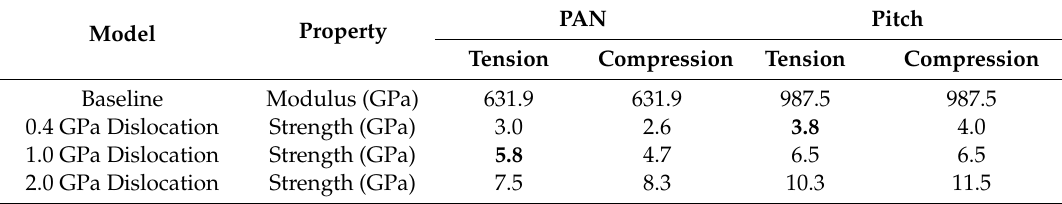
Figure 10. Tensile and compressive simulation stress/strain curves and final properties using crack dislocations between multiscale RVEs. ( a ) For pitch-based; ( b ) For PAN-based carbon fibers. Table 3. Summary of modulus and strength results from Figure 10.